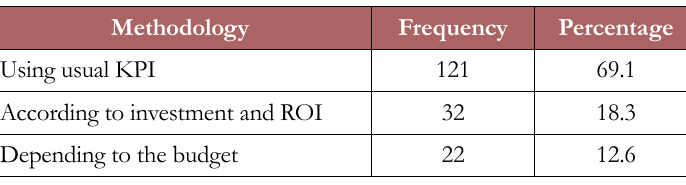
Table 6. Techniques used to prioritise improvement